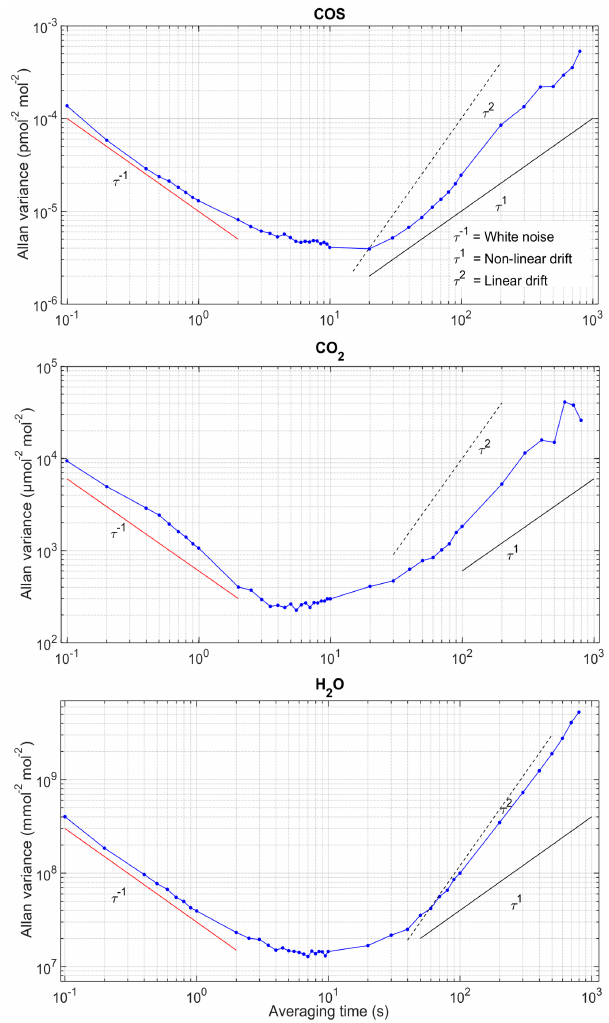
Figure 2. Plots of the Allan variance (blue symbols and lines) as a function of the averaging time ( τ ) as described in Werle (2010). The time series was obtained under ambient conditions in the instrument hut in the field by providing pressurised air from a cylinder to the QCLAS. The red line indicates the expected decline of the variance with increasing averaging time in case of white noise; the black dashed and solid lines are the expected increase in variance due to non-linear and linear drift,